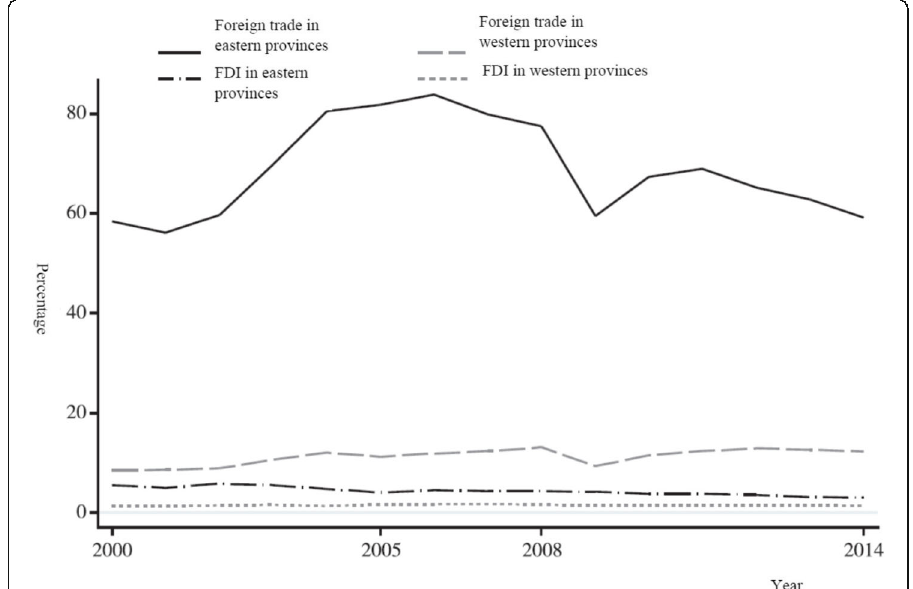
Fig. 4 Level of globalization in eastern China and western China(Source: China Statistical Yearbook, 2000 – 2015, calculated by the